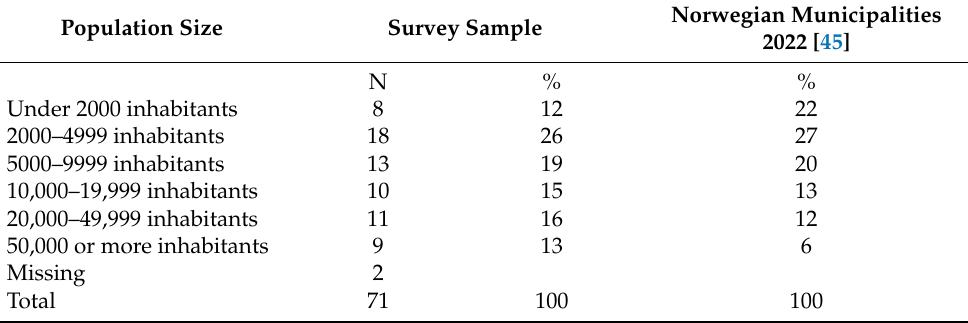
Table 2. Categorization of included